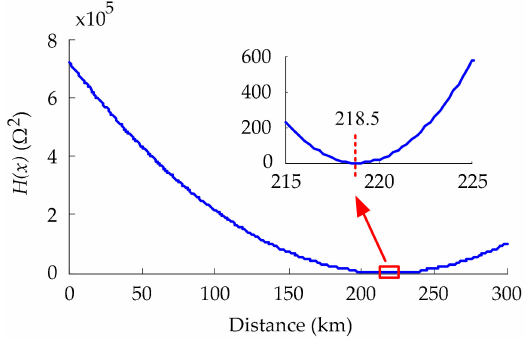
Figure 10. Location result under the phase-A-to-ground